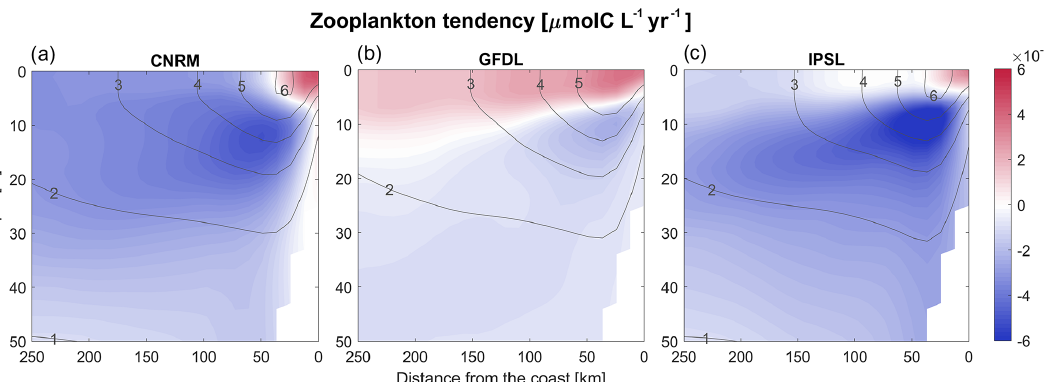
Figure 16. (a–c) Annual vertical sections of the RCM zooplankton linear trends (µmolCL − 1 yr − 1 ). The vertical cross-shore section corre- sponds to an alongshore average of cross-shore sections between 7 and 13 ◦ S. Contours represent the mean control values